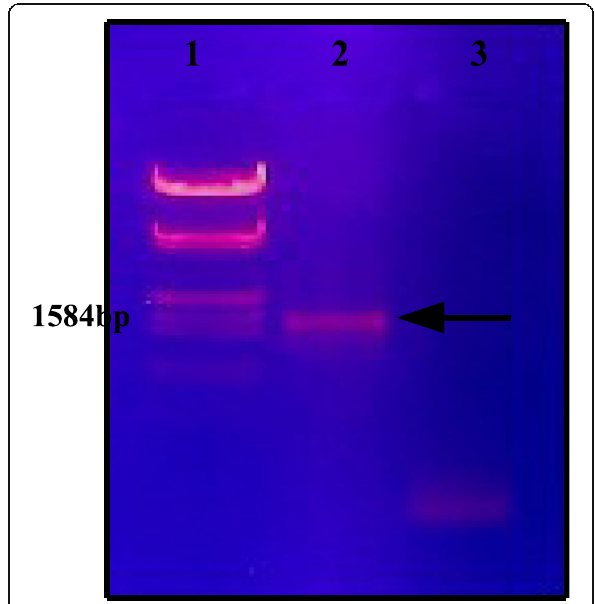
Fig. 2 PCR amplification of cellulase gene from B. subtilis genome on 1% agarose gel. Lane 1, λ DNA Eco RI /Hind III marker (Thermo Scientific); lane 2, cellulase amplicon; lane 3, non-template